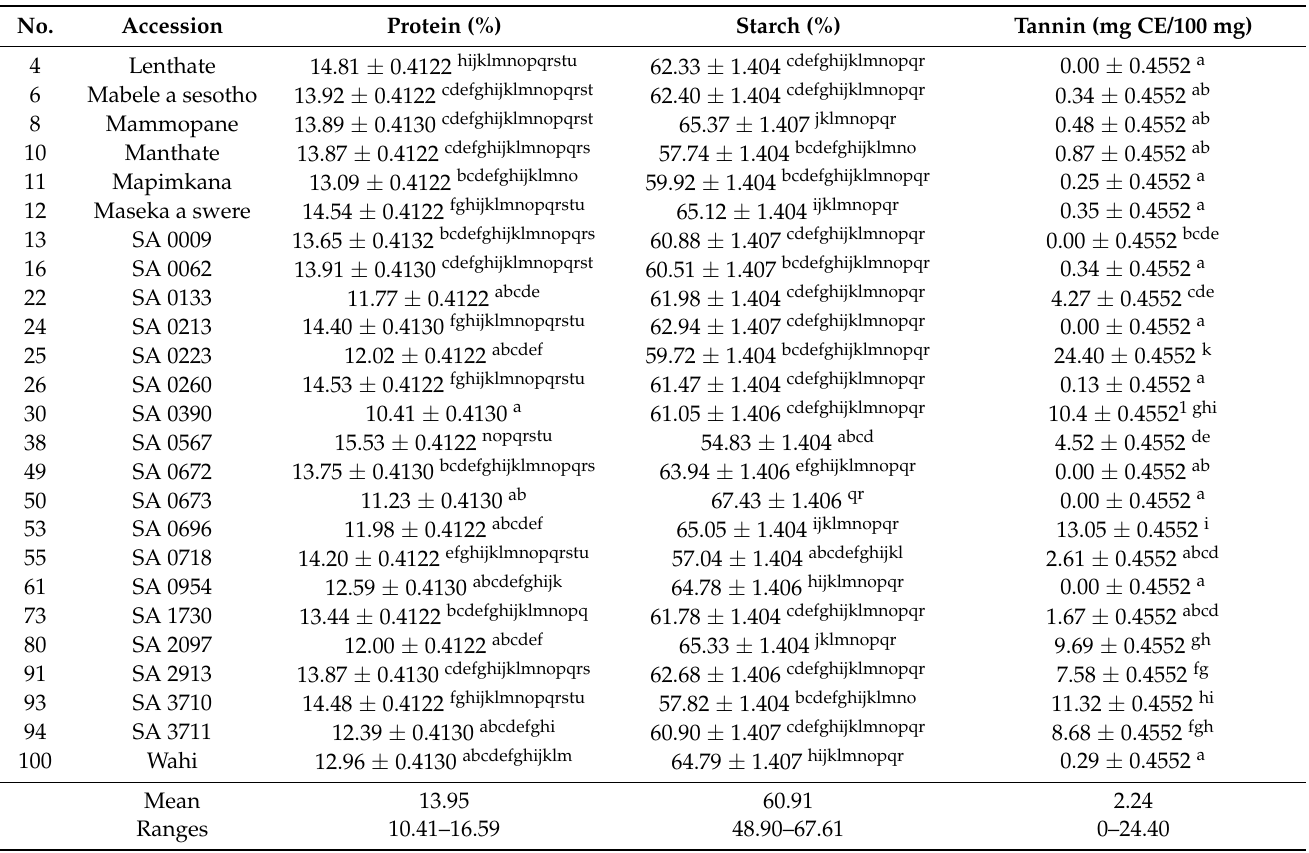
Table 2. Mean values of grain protein, starch, tannin, moisture and yield, and sorghum types based on tannin